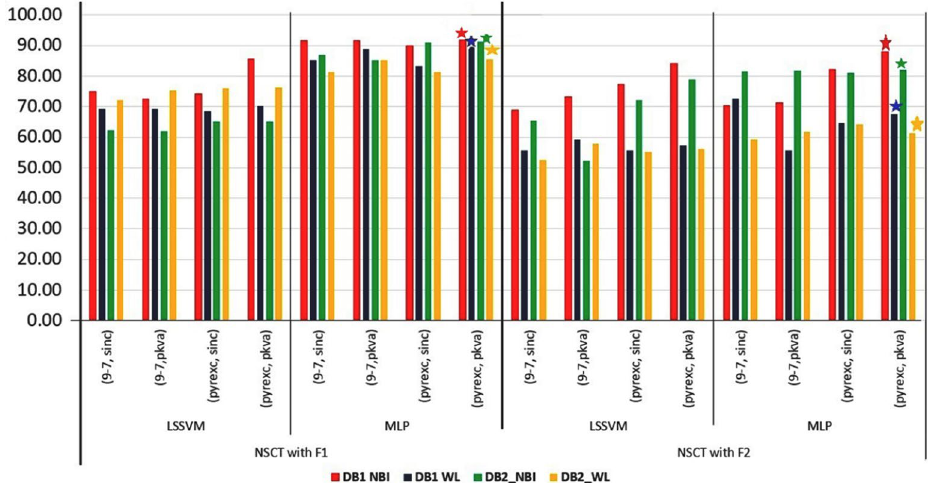
Figure 4. Result of NSCT features before feature selection.